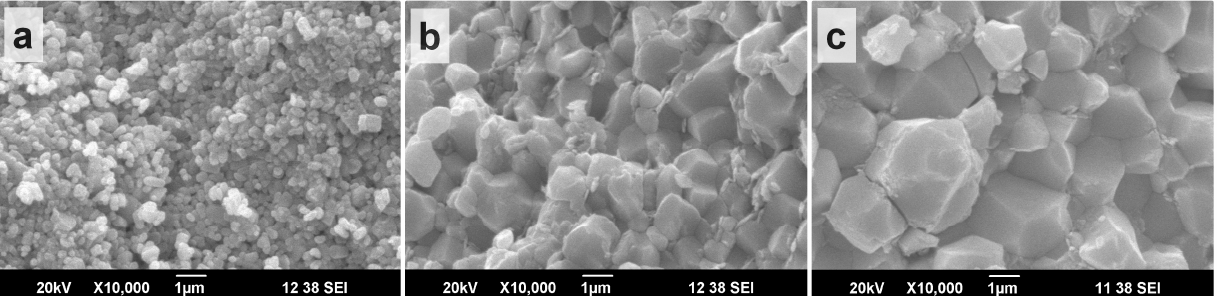
Figure 12. SEM images of ZnO ceramics prepared from powder impregnated by 0.5 wt.% ZnAc ( a ), 2.5 wt.% ZnAc ( b ), 5.0 wt.% ZnAc ( c ) (case of 2P sealing type during CSP).